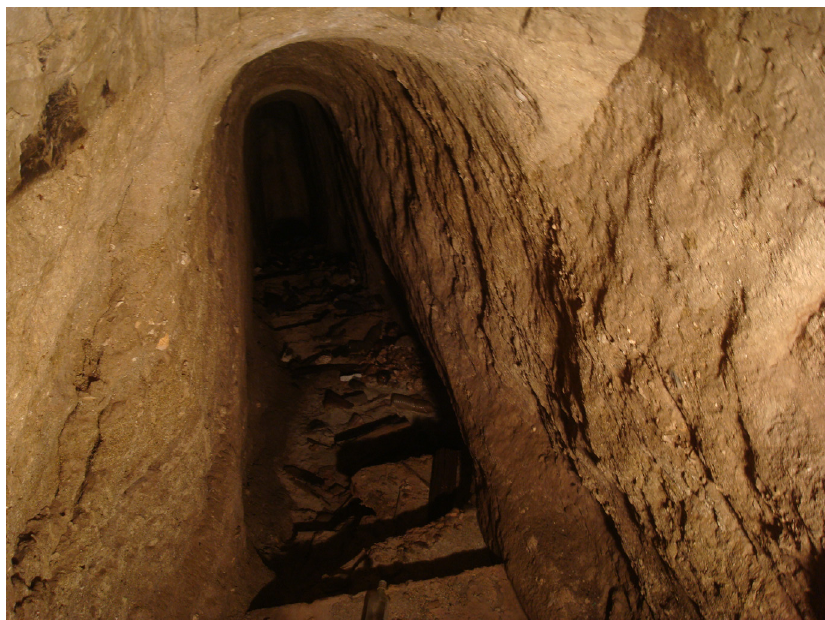
Figure 13. A general view of the entrance in a well